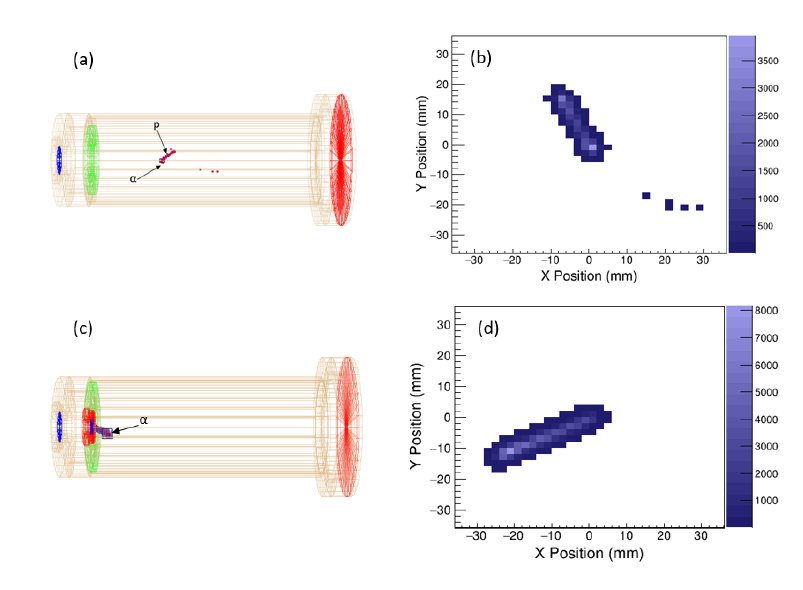
Figure 1. Panel (a) and (b)-ATTPCROOTv2 simulation of GADGET’s TPC for 20 Mg( β p α ) 15 O, 3D render and 2D projection. Panel (c) and (d)-ATTPCROOTv2 simulation of GADGET’s TPC for 241 Am α -decay sequence, 3D render and 2D